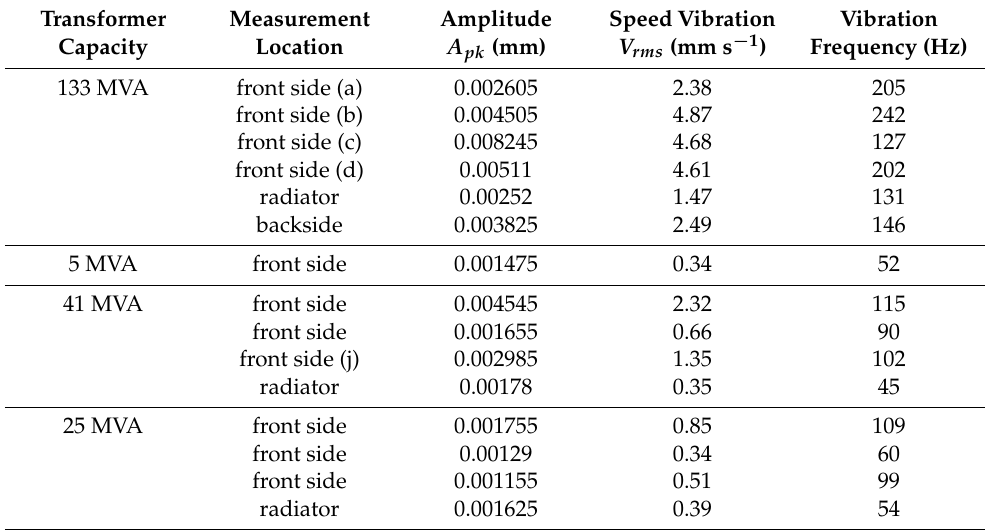
Table 4. Frequency calculation results from measuments obtained from transformers. Locations are indicated in Figure